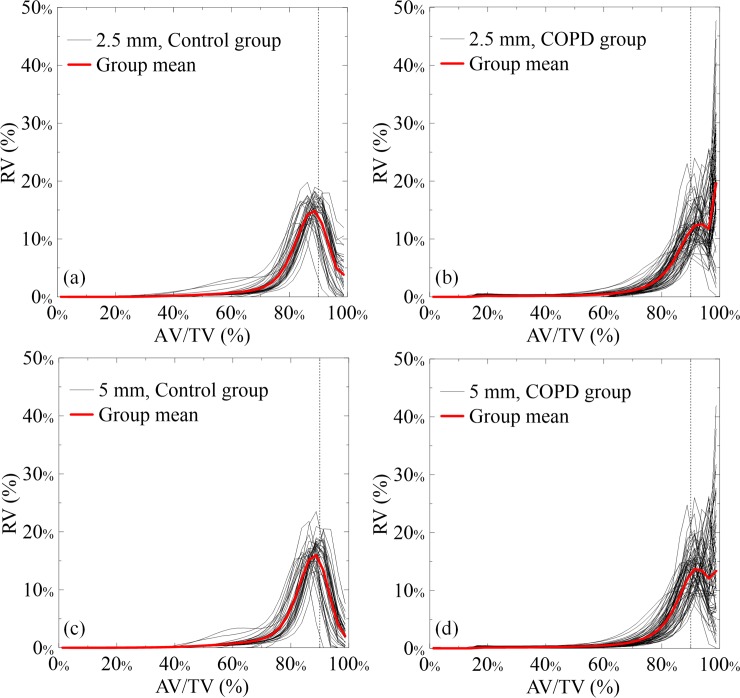
(a) and (b) RAVHs of the control and COPD groups calculated from the 2.5-mm-thick CT images, respectively. (c) and (d) RAVHs of the control and COPD groups calculated from the 5-mm-thick CT images, respectively. The group-mean RAVHs (red bold lines) are shown.